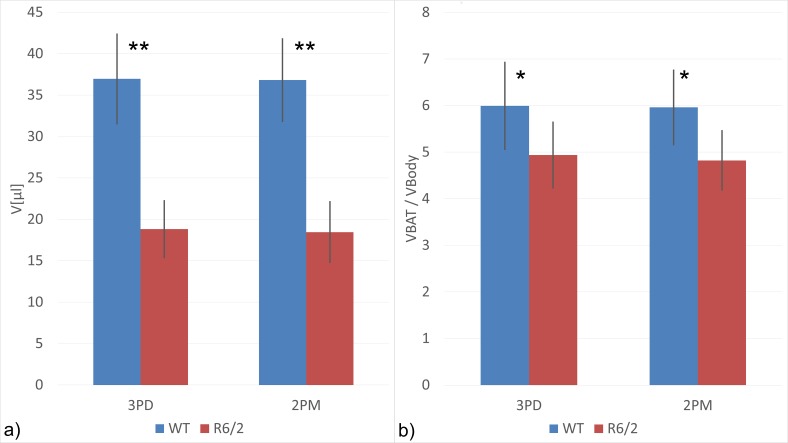
Total BAT volumes a) and BAT volumes normalized to total body volume b) for female HD-transgenic (R6/2) and matched wild-type control mice.(n = 5 per group; *P<0.05, **P<0.01; unrelated Wilcoxon Rank sum test; columns (error bars) represent means (standard deviation)).